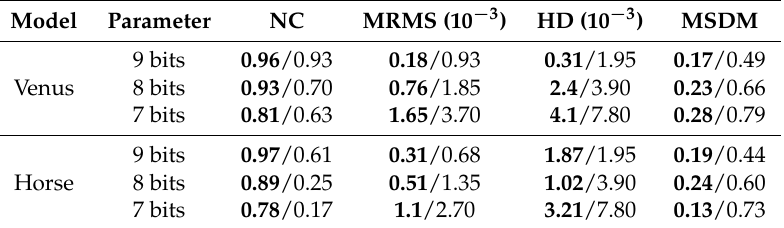
Table 19. Results of quality and robustness comparison with Wang et al.’s scheme [3] against quantization measured in terms of MRMS, HD, MSDM, and NC.